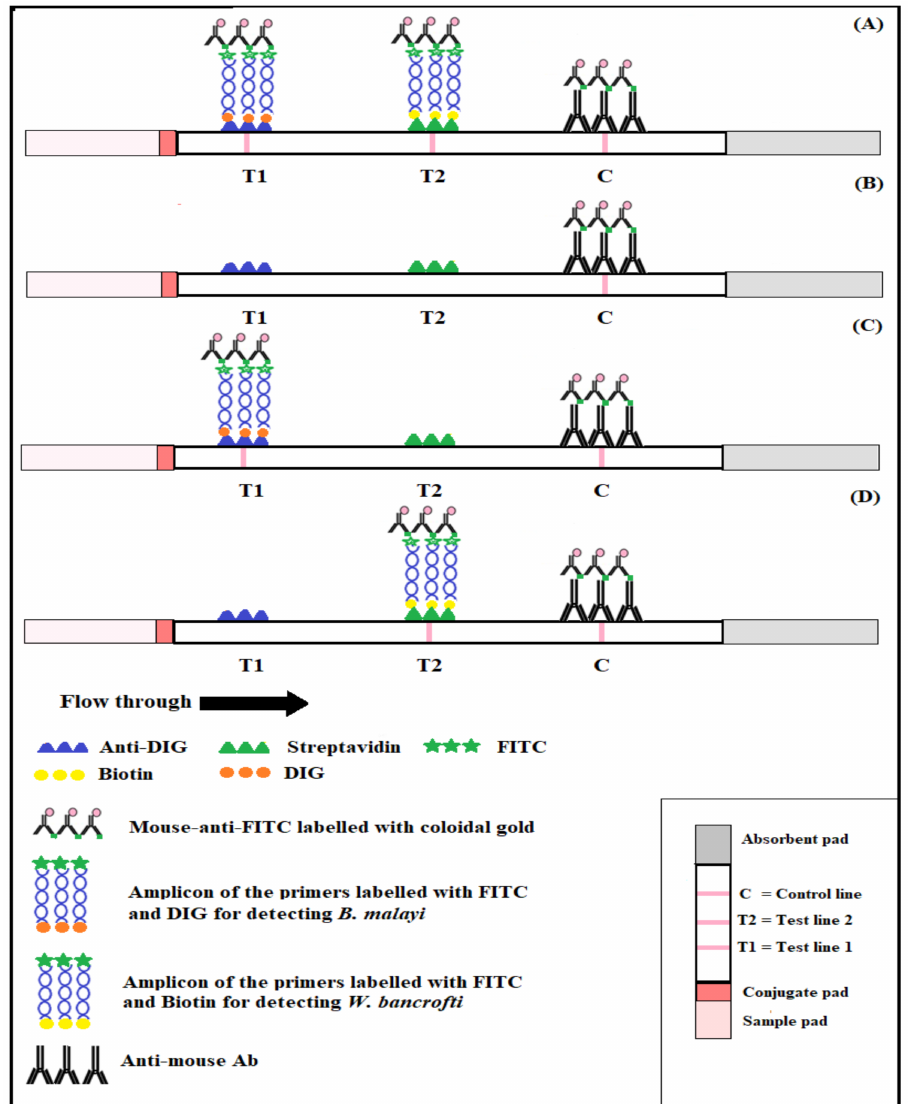
Figure 2. Schematic illustration of the duplex lateral flow dipstick (DLFD) for two target detec- tions. T1 = test line 1 for detecting Brugia malayi ; T2 = test line 2 for detecting Wuchereria bancrofti ; C = control line. ( A ) = positive control; ( B ) = negative control; ( C ) = positive for W. bancrofti ; ( D ) = positive for B. malayi